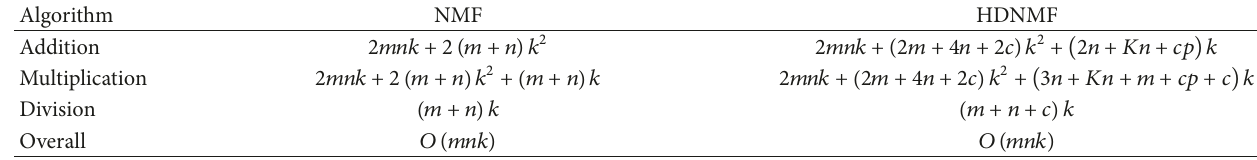
Algorithm 1: The algorithm of HDNMF. Table 1: Computational operation counts for each iteration in NMF and HDNMF.